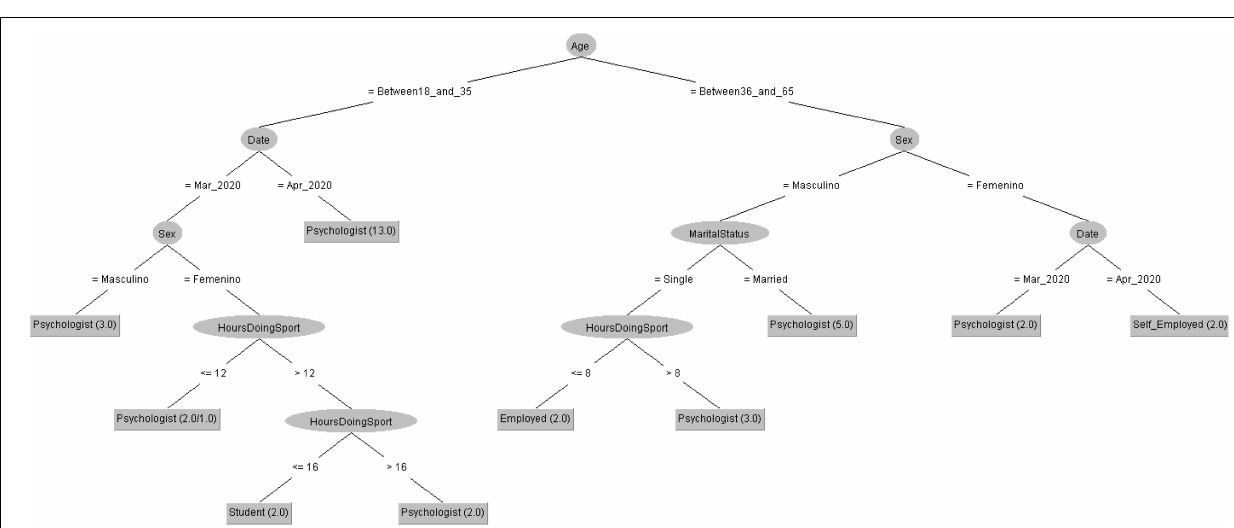
FIGURE 8 | Profession of people taking the STAI questionnaire in 2020 decision